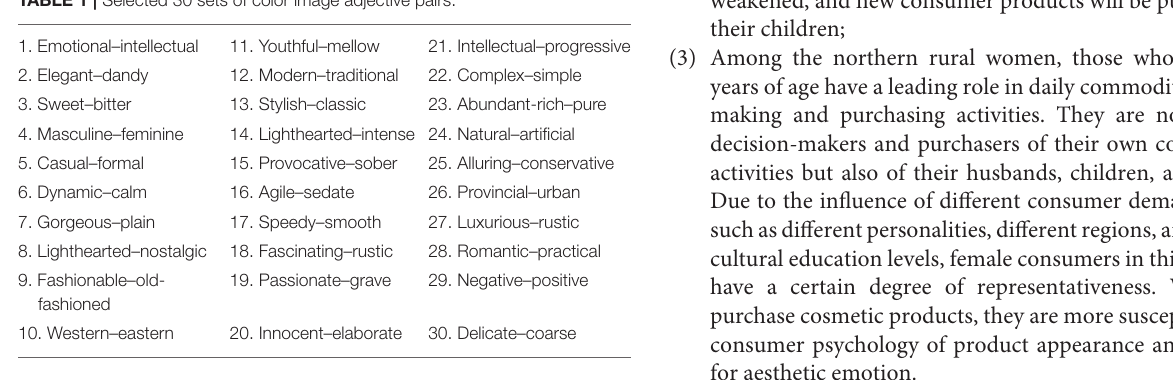
TABLE 1 | Selected 30 sets of color image adjective